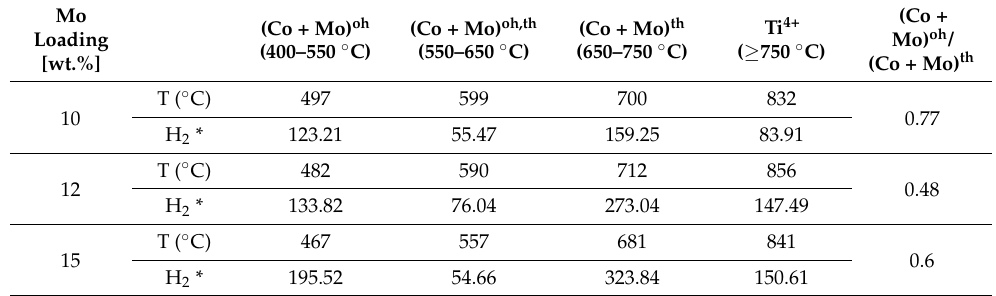
Table 4. H 2 consumption for Co and Mo species involved in the CoMo/AT2 using different loadings of Mo: 10, 12 and 15 wt.%.